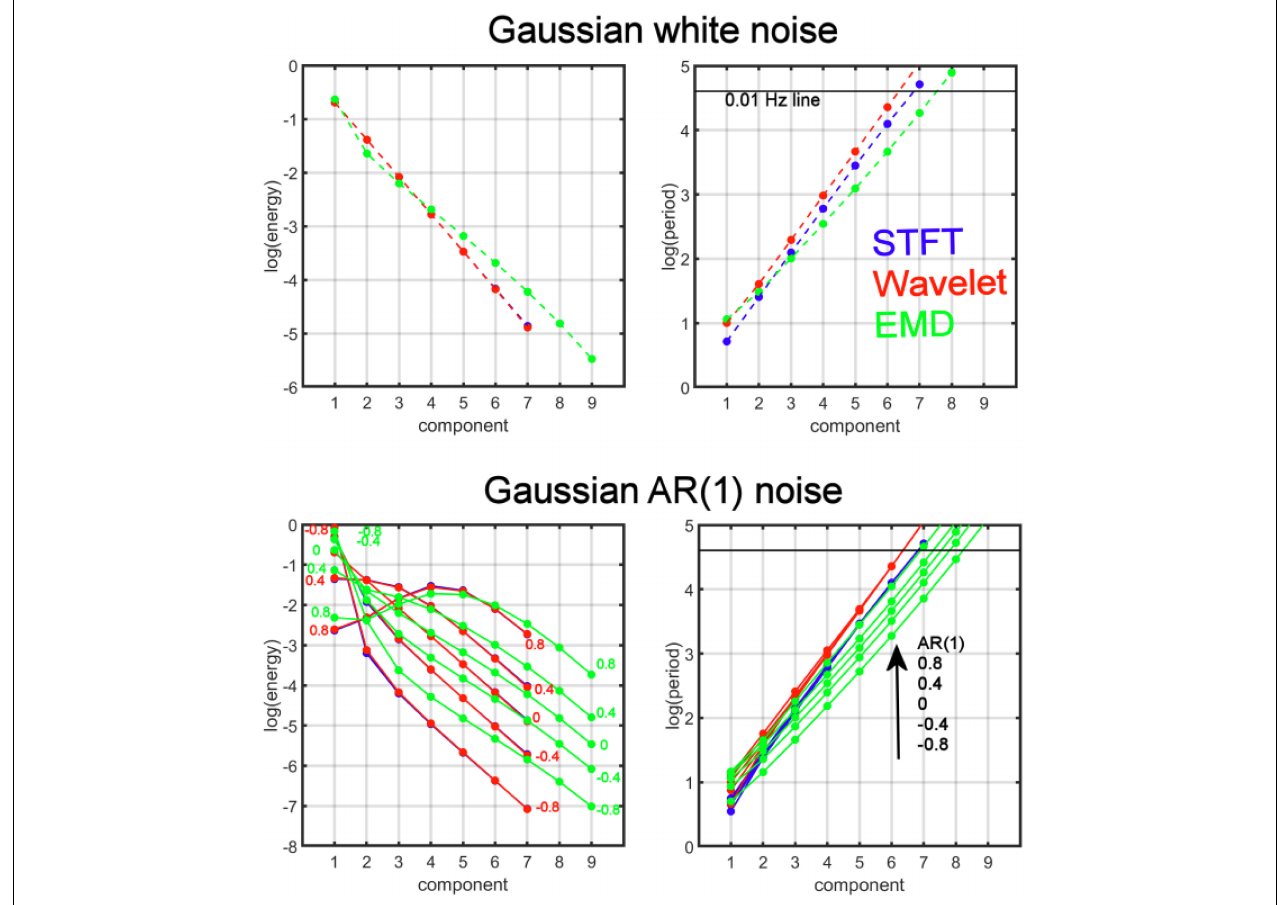
FIGURE 3 | Comparison of the average energy and period distributions for simulated Gaussian white noise (top) and AR(1) noise (bottom) for AR(1) values φ = {− 0 . 8 , − 0 . 4 , 0 , 0 . 4 , 0 . 8 } as a function of the decomposition level (component) and for three different analysis methods: Empirical Mode Decomposition (EMD, green), Maximal Overlap Discrete Wavelet Transform (Wavelet, red), and Short-Time Fourier Transform (STFT, blue). For EMD the different components are the IMFs, whereas for the wavelet transform the detail levels are the components, and for STFT the different dyadic frequency intervals are the components. The numbers in the figure indicate the values of the AR(1) coefficient. The black horizontal line corresponds to the 0.01 Hz line indicating the border to the drift frequency range in fMRI. Components with periods above this line are most likely associated with artifacts and are of no interest in this study. Note that log(period) shows approximately linear dependence as a function of the components for all methods. In particular, the AR(1) coefficient associated with the lines for log(period) increases in the direction of the arrow (toward larger periods). The log(period) dependence on the AR(1) coefficient is largest for EMD (see large spread of the 5 green lines) and very small for STFT and wavelet, especially for components larger than 1 (with a spread close to zero for the 5 red lines (or 5 blue lines)). Also, the lines for EMD have a smaller slope when compared to STFT and MODWT. The energies for STFT and MODWT are the same (red and blue energy curves